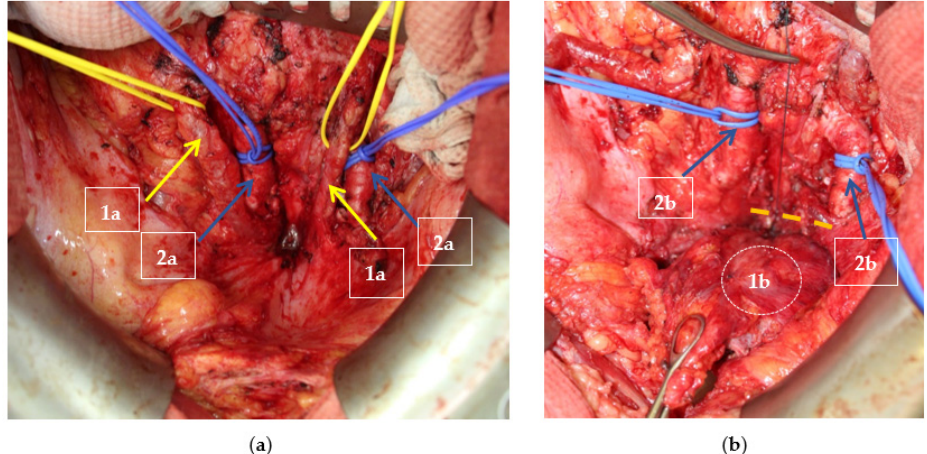
Figure 5. ( a ) Intraoperative view of the pelvis. Performed control of bleeding. 1a—ureters; 2a—common iliac arteries; ( b ) Resection of the ureters was performed, the bladder was mobilized, and the border of the tumor was determined using augmented reality technology. 1b—mobilized bladder; 2b—common iliac arteries. The boundary of the tumor invasion into the sacrum is indicated by a ligature and a dotted